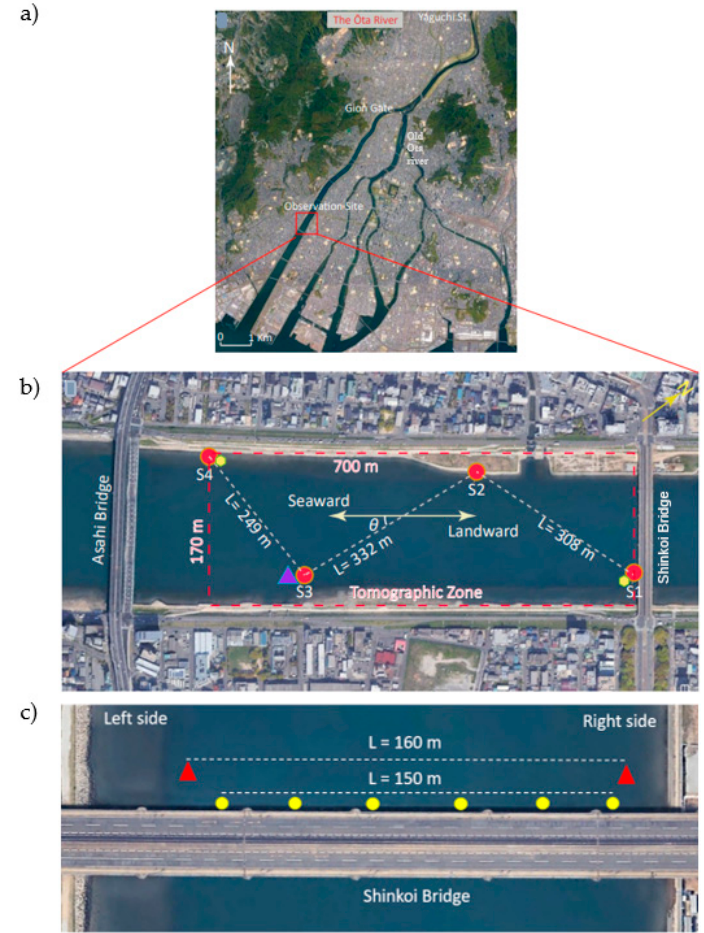
Figure 1. ( a ) The location of the field observation at the Ō ta River Estuary; ( b ) the arrangement of the tomographic scheme of the FAT system over the Ō ta River. Yellow and purple symbols indicate the locations of the CT instruments; and ( c ) the Compact CTD (yellow circles) and FAT (red triangles) campaigns for validating section ‐ average salinity using the FAT system.